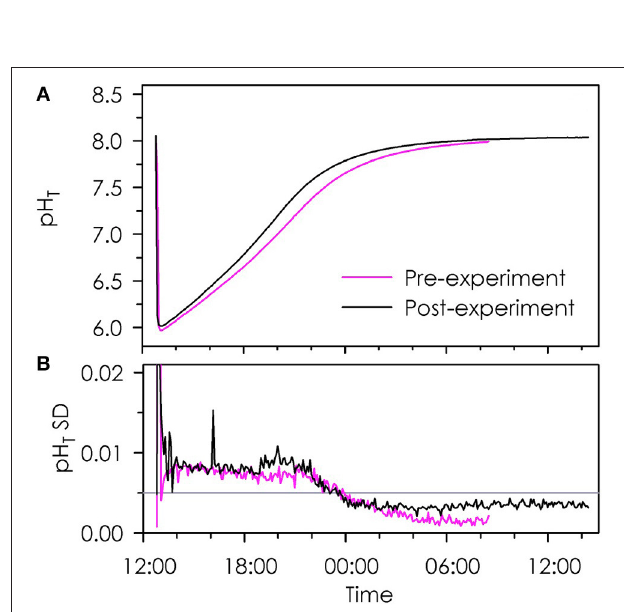
FIGURE 5 | Time-series of mean pH T (A) and standard deviation (B) of eight Durafets during CO 2 spikes prior to (pink) and after (black) being used in an experiment ( Figure 4 ). Reference line in (B) indicates a standard deviation of